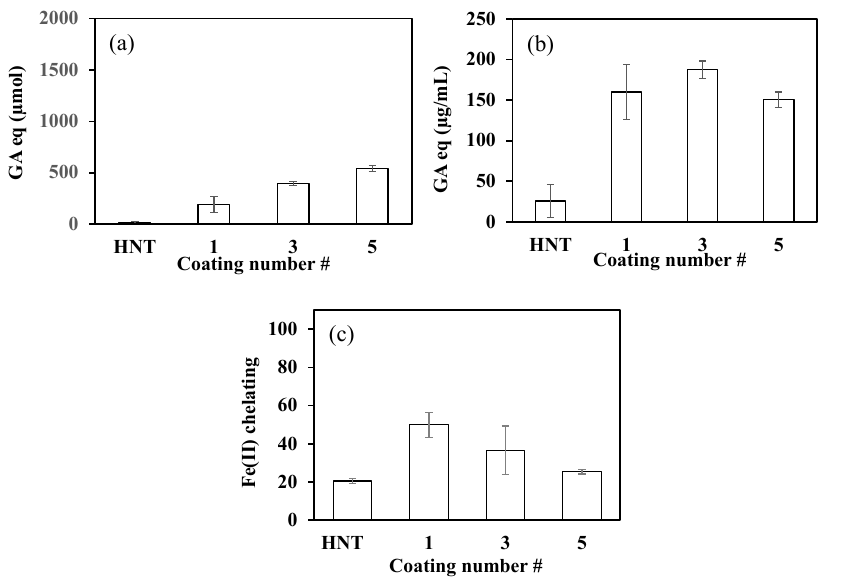
Figure 5. ( a ) TPC values, ( b ) TFC values, and ( c ) Fe(II) chelating capacities (%) of HNT and PDOPA@HNT particles.